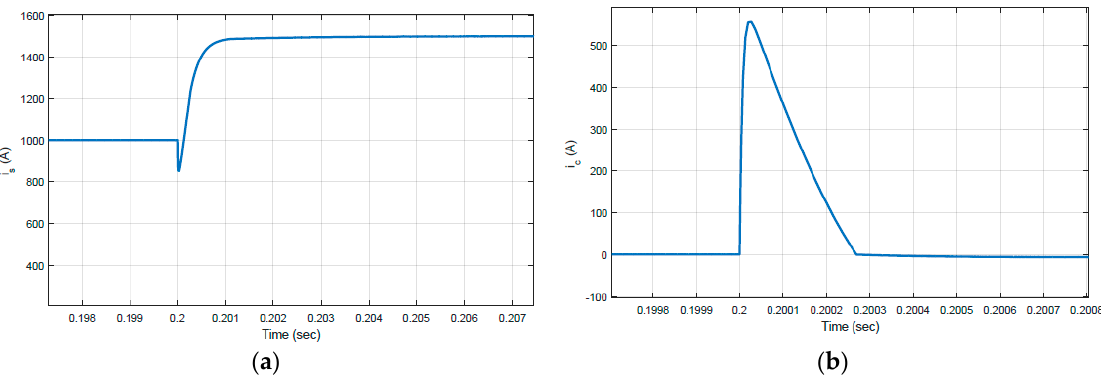
Figure 7. Load change simulation results. ( a ) Source current and ( b ) capacitor current.